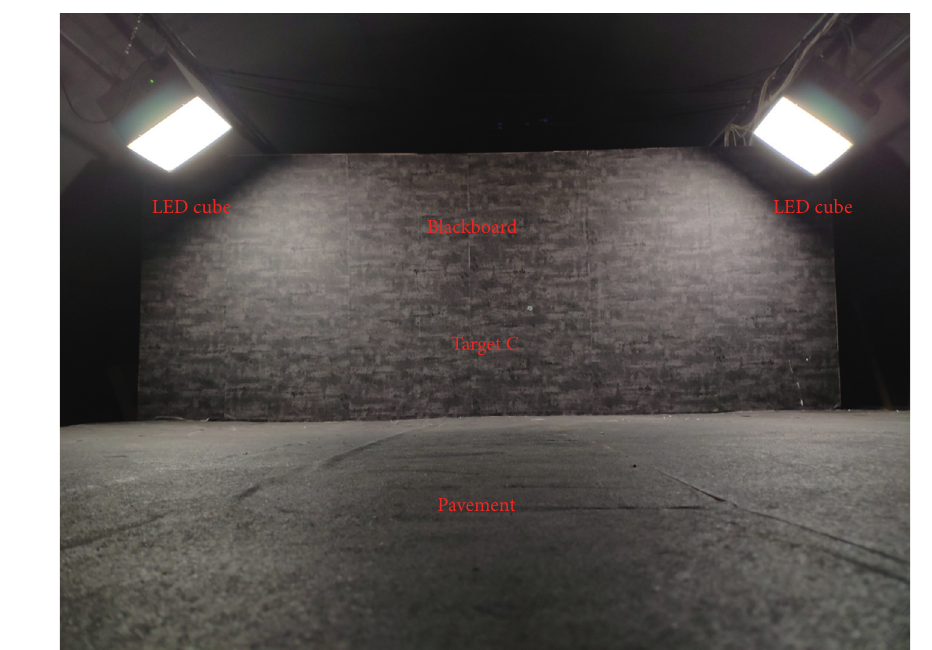
Figure 10: Schematic diagram of the simulated